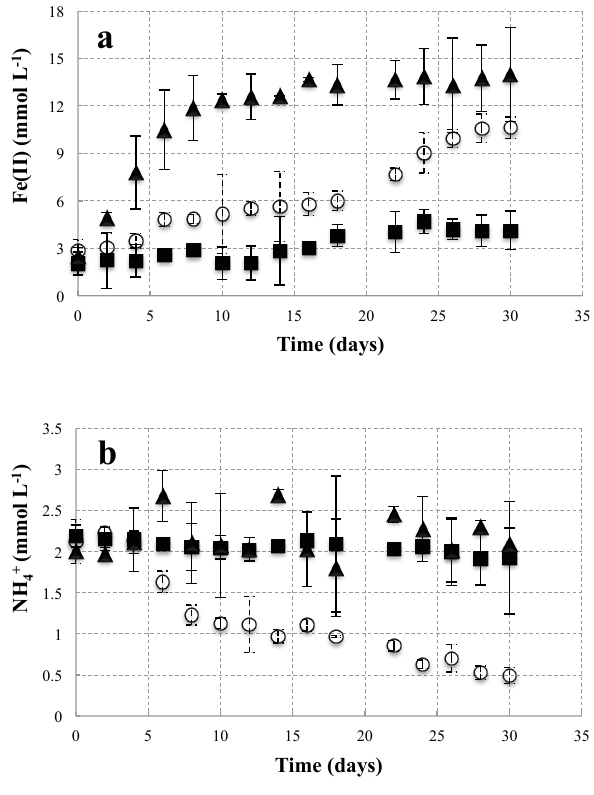
Figure 1. Concentration of Fe(II) and NH + different Fe(III) sources: ferrihydrite ( ◦ ), ferric chloride ( (cid:4) ), and ferric citrate ( (cid:78) ). The values represent the mean and standard error ( n = 3).